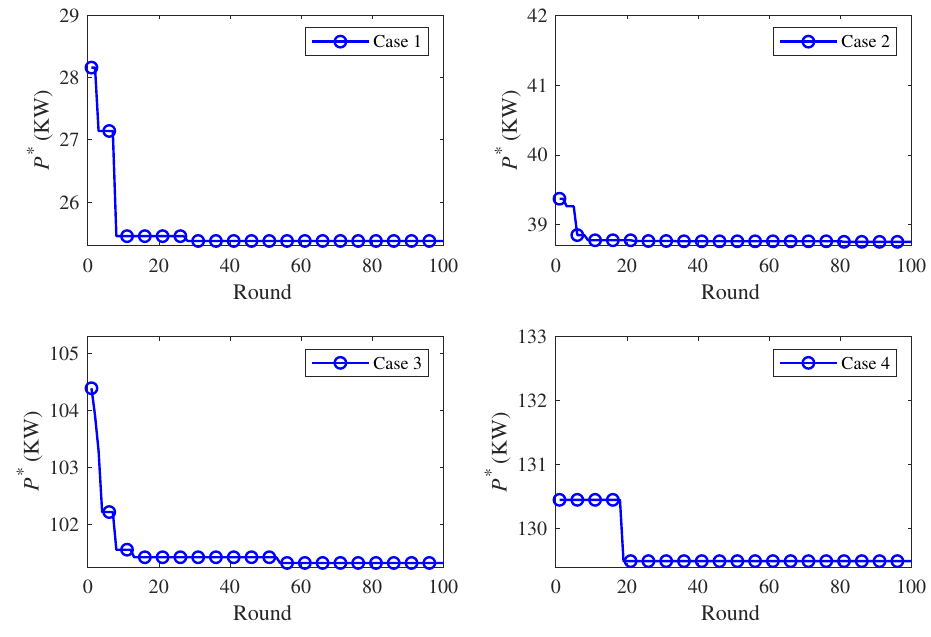
Figure 5. The iteration of BRS under four cases.